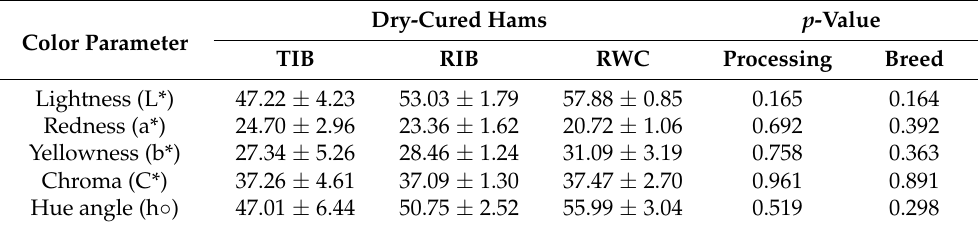
Table 4. Effect of Iberian dry-cured ham type (processing) and effect of breed on instrumental color. Results are expressed as mean values ± SEM.